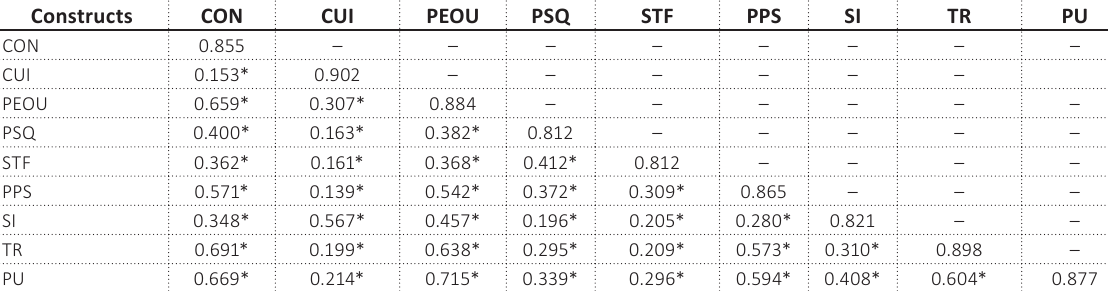
Table 4. Discriminant analysis Constructs